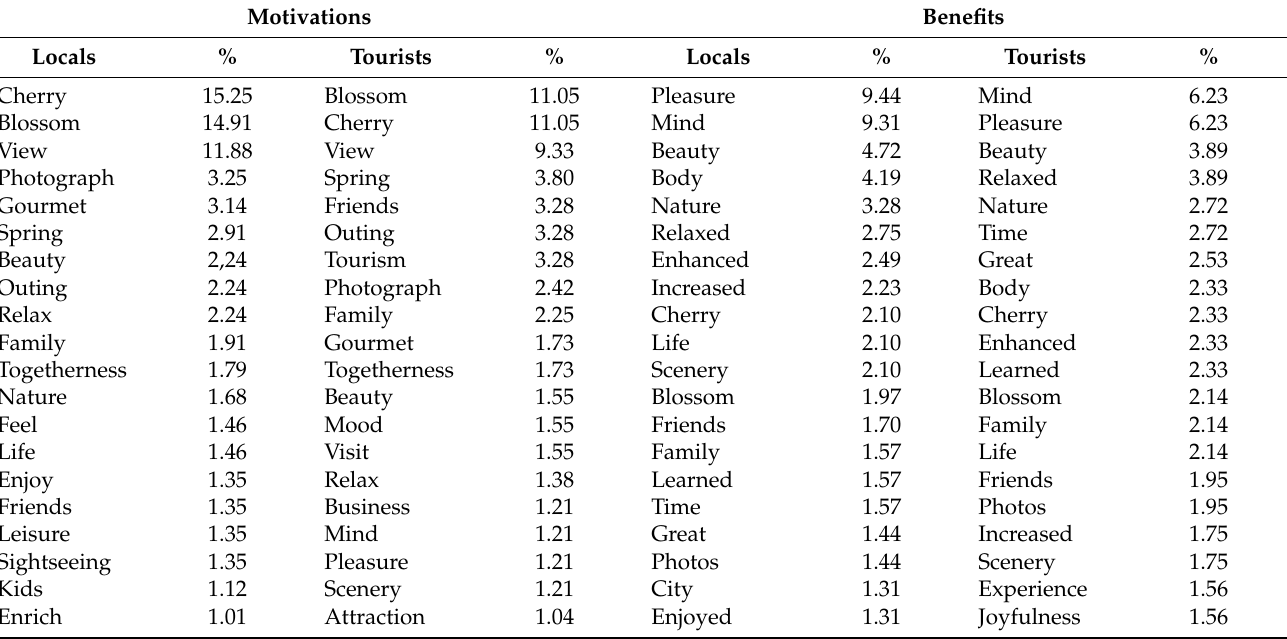
Table 2. Frequency of words for locals and tourists.